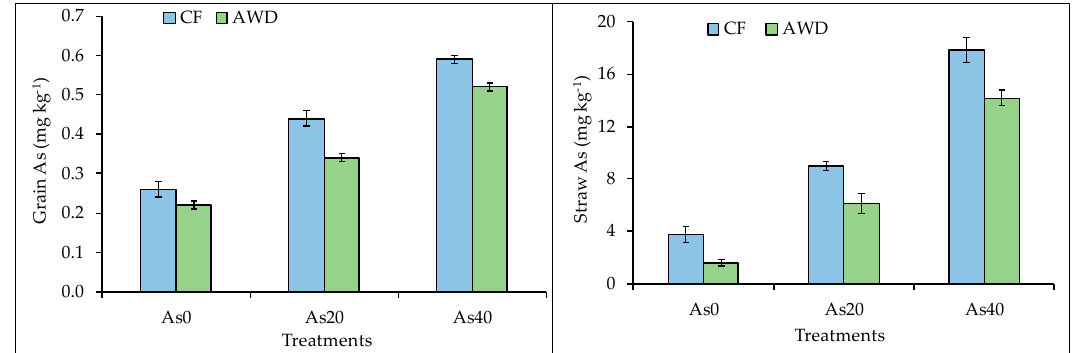
Figure 1. Grain and straw As concentrations of rice (cv. BRRI dhan28) under different soil As concentrations (0 mg kg − 1 As, 20 mg kg − 1 As, 40 mg kg − 1 As) and irrigation water management (CF = continuous flooding, AWD = alternate wetting and drying).